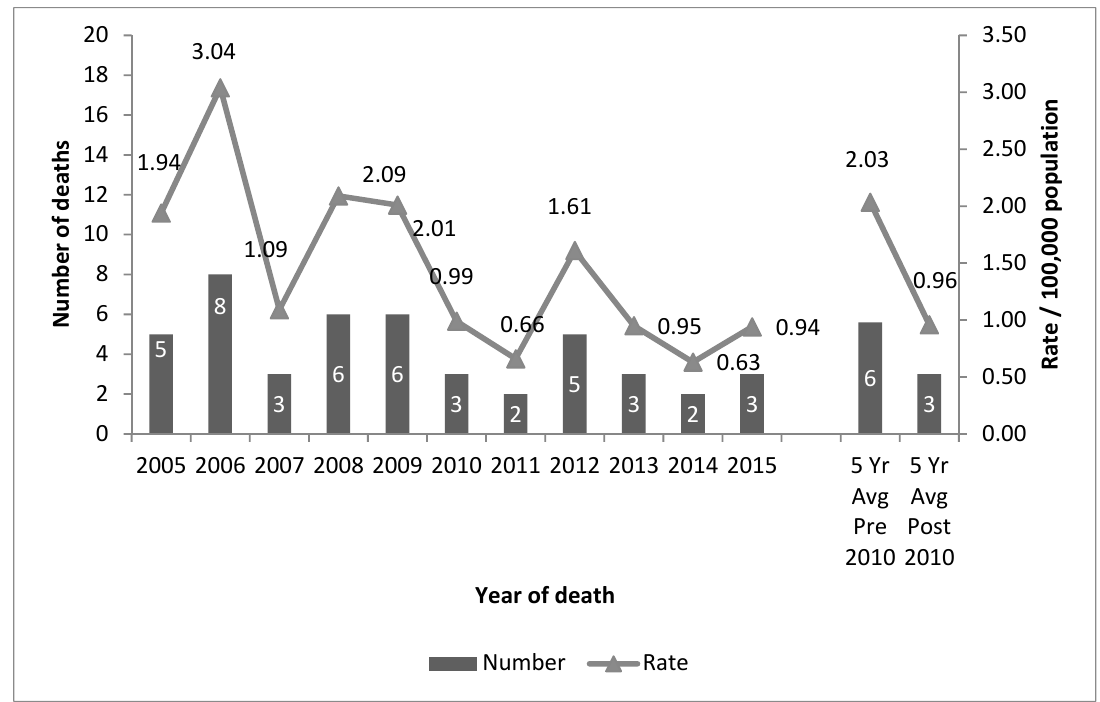
Figure 4. Unintentional fatal drowning in children aged 0–4 years in private swimming pools Queensland, 2005–2015 ( N = 46).